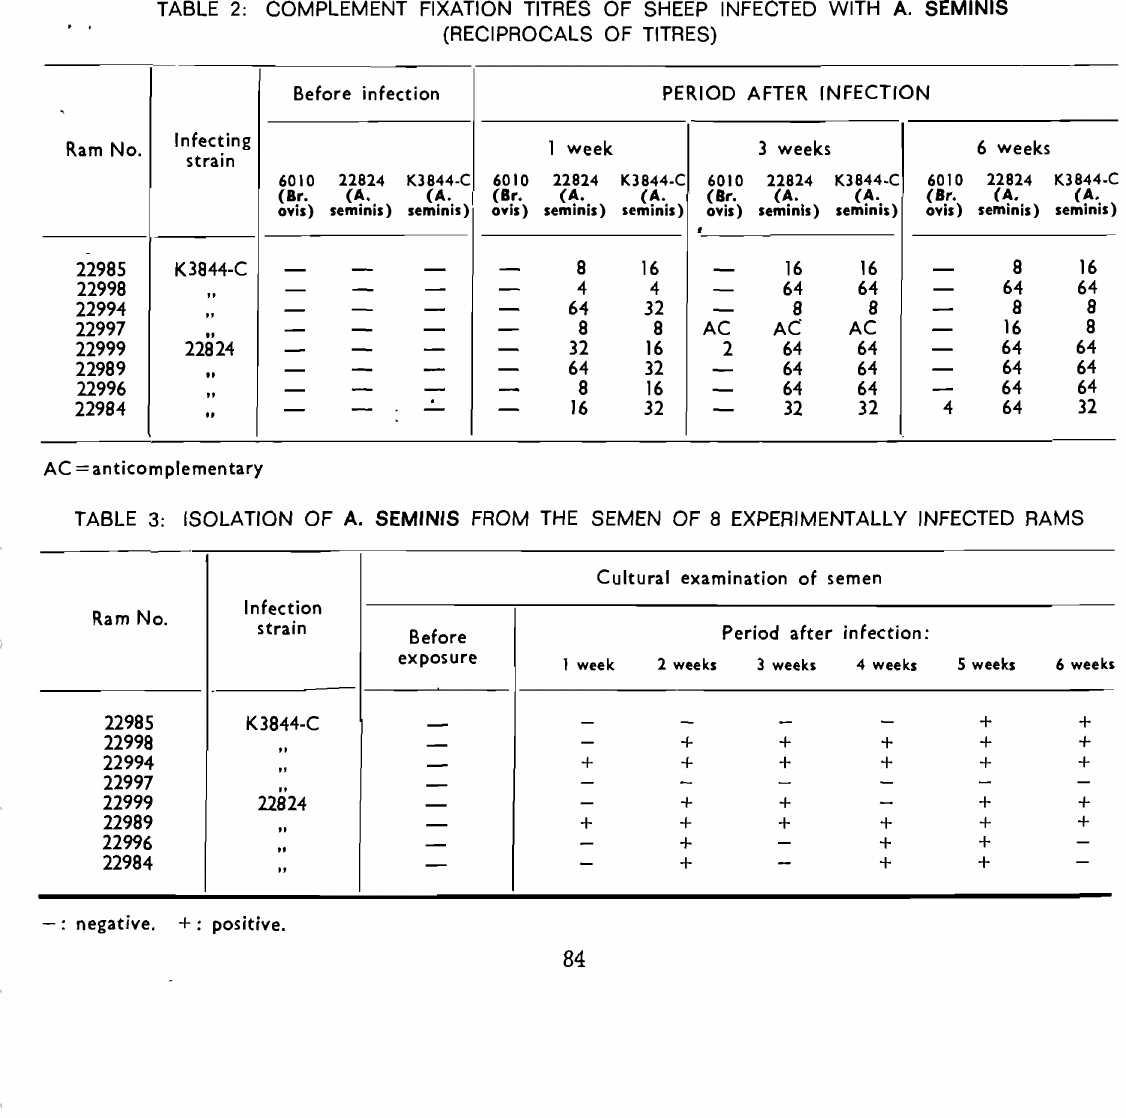
TABLE 2: COMPLEMENT FIXATION TITRES OF SHEEP INFECTED WITH A. SEMINIS (RECIPROCALS OF TITRES) Before infection PERIOD AFTER INFECTION Ram No.